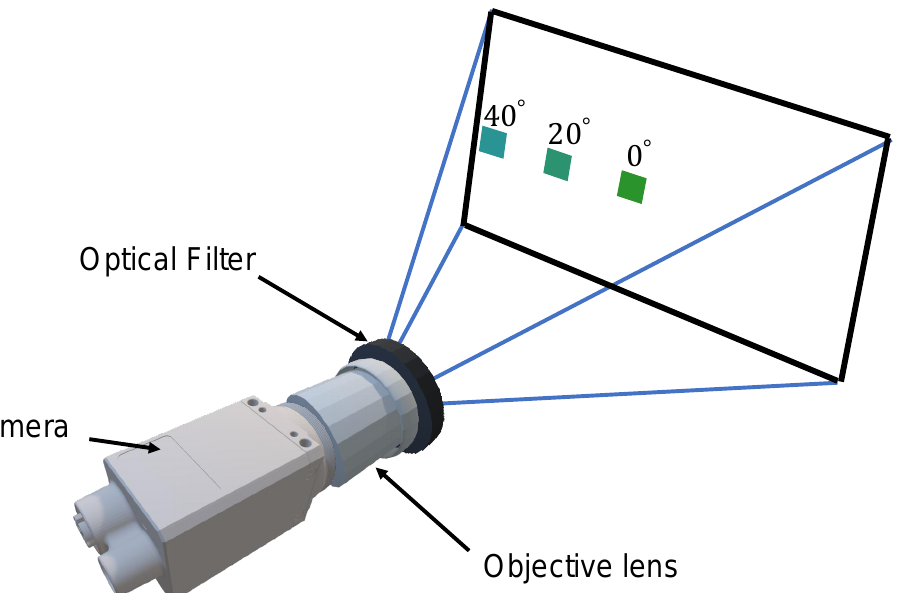
Figure 1. A schematic illustration of the color shift that happens in the object’s color with the angle. A green patch is used to illustrate the color shift problem caused by the optical filter. As the green patch gets closer to the edge of the field of view, its color shade